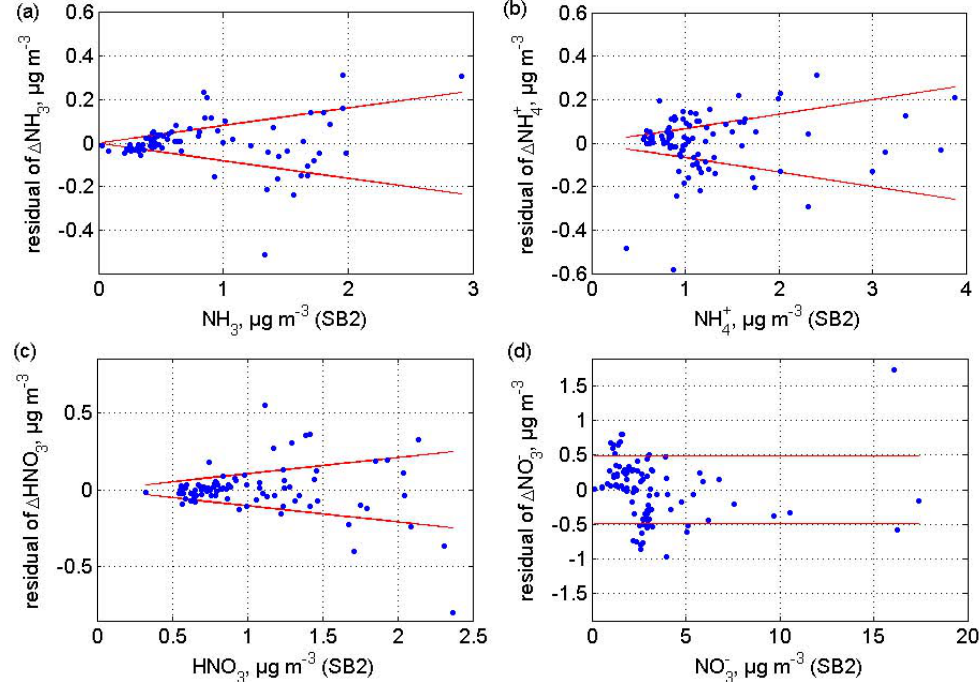
Fig. 11. Residuals of 1C during side-by-side after correcting the data for systematic deviations using the orthogonal fit (individual values: blue points) and their relation to C during EGER. The derived σ 1C is shown as red line (uncertainty range around